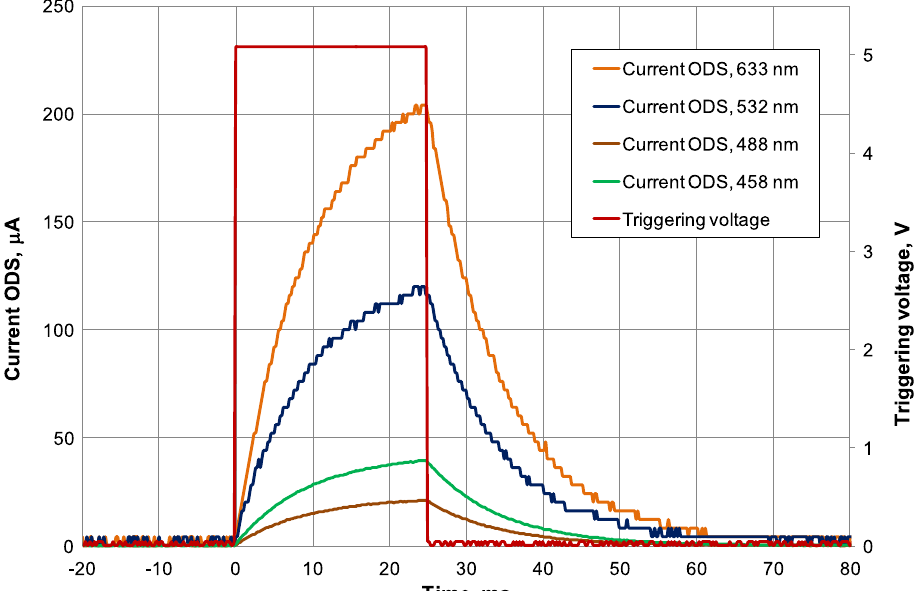
Fig. 8. Time-resolved spectrally fi ltered optical signal of the short-pulse driven CoB (ID VSL085). Triggering electrical forward voltage is shown in red for reference.